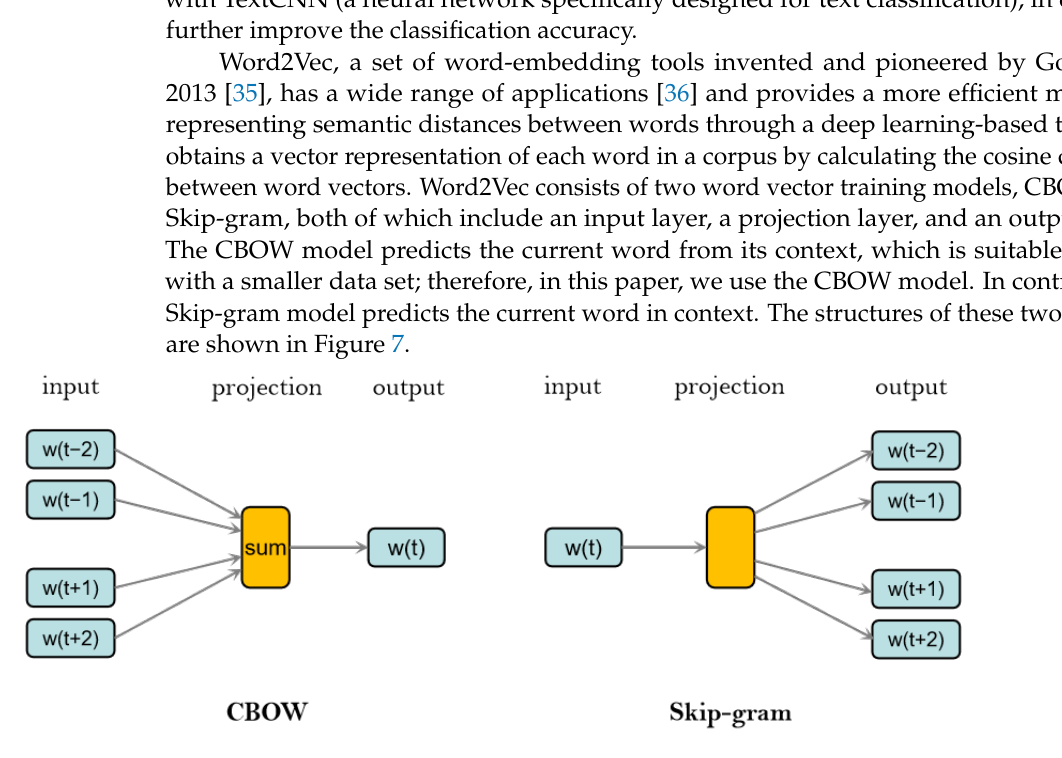
Figure 6. Comparison between DPCNN and DPCNN-upgrade structures.